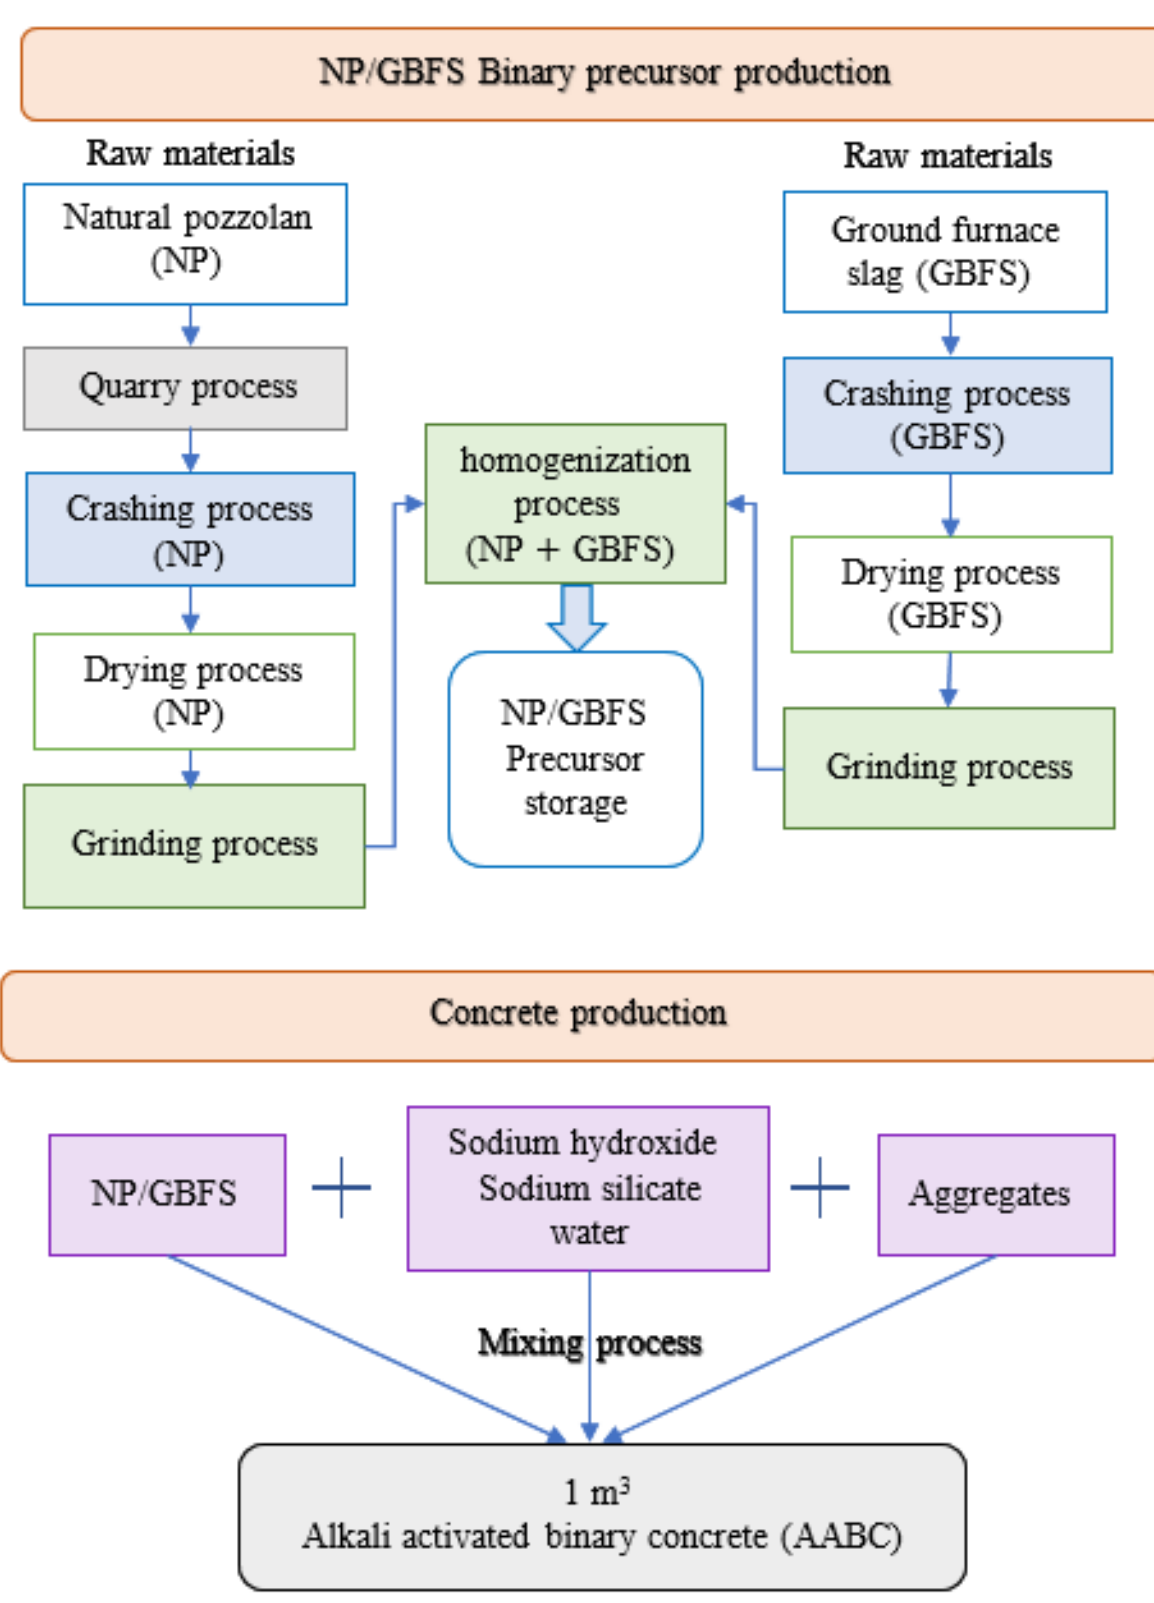
Figure 6. Life cycle stages from cradle to gate for AABC concrete production.